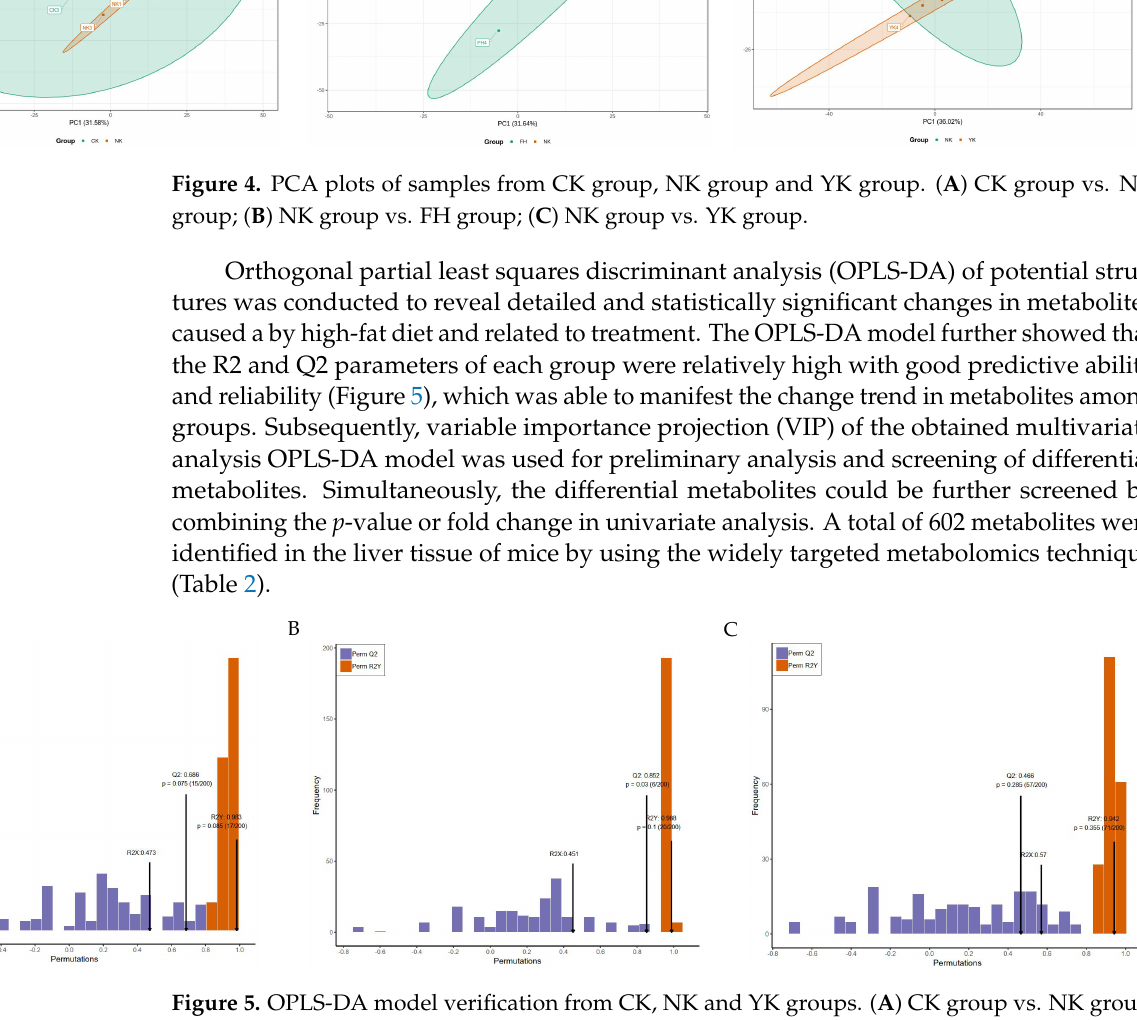
Figure 5. OPLS-DA model verification from CK, NK and YK groups. ( A ) CK group vs. NK group; ( B ) NK group vs. FH group; ( C ) NK group vs. YK group. Table 2. Significant changes in potential metabolites were identified by LC—MS in mice liver in- duced by HFD.